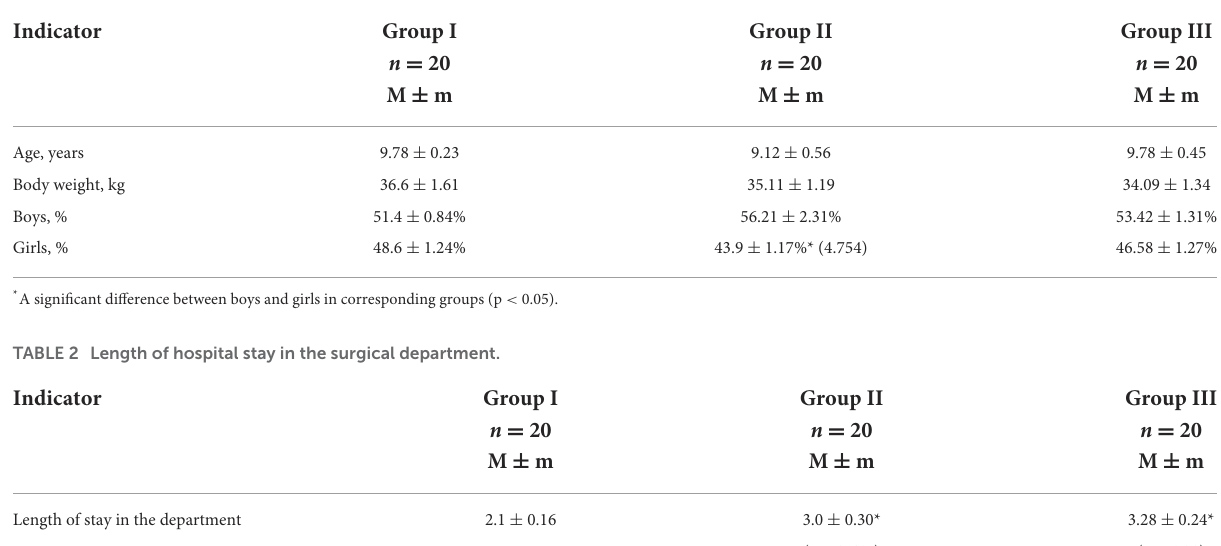
TABLE 1 Distribution of patients by age, body weight, and